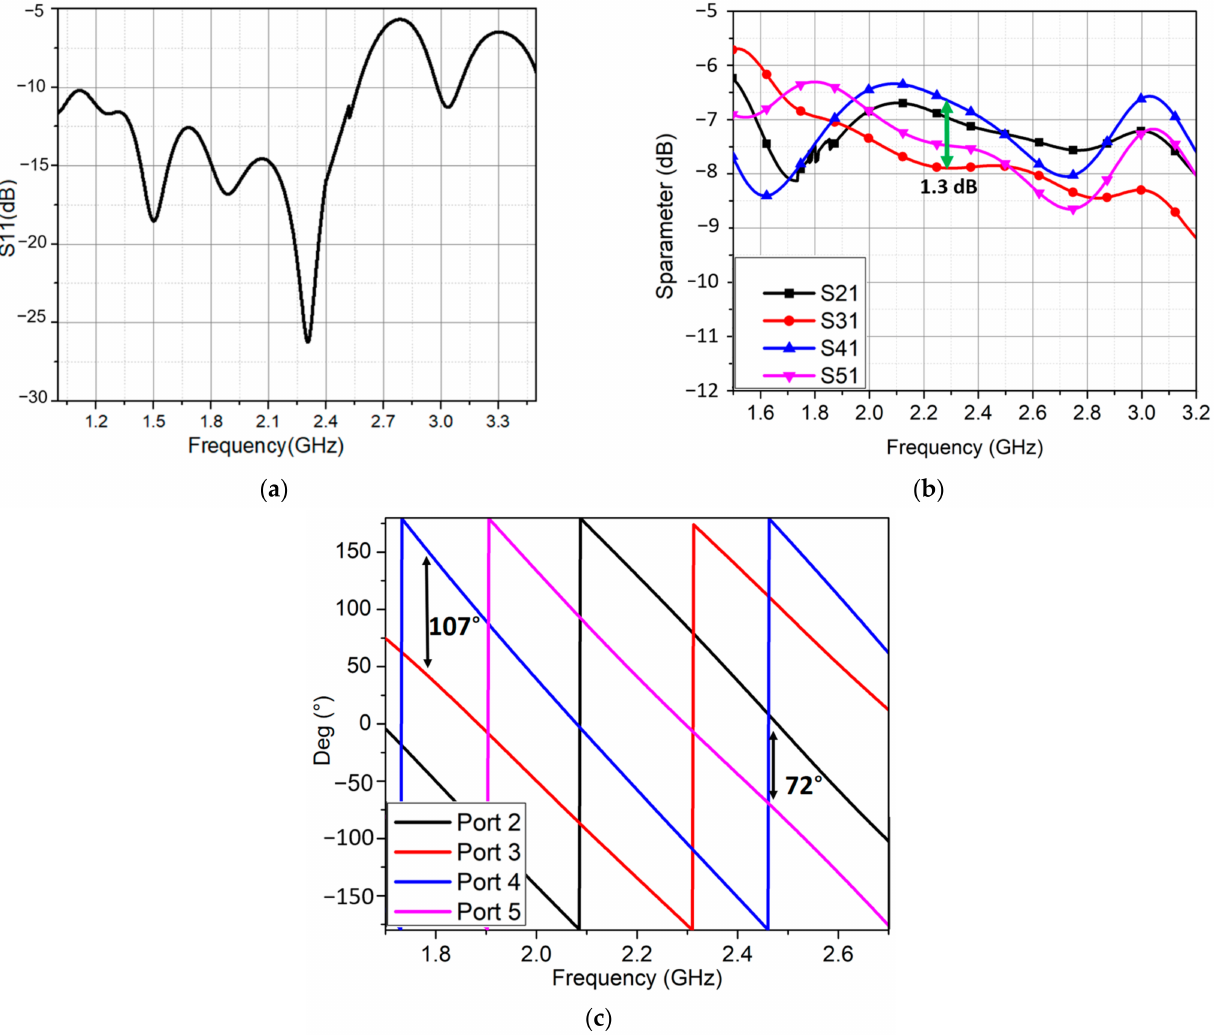
Figure 5. The feeding network performances. ( a ) Reflection coefficient; ( b ) amplitude distribution; ( c ) phase